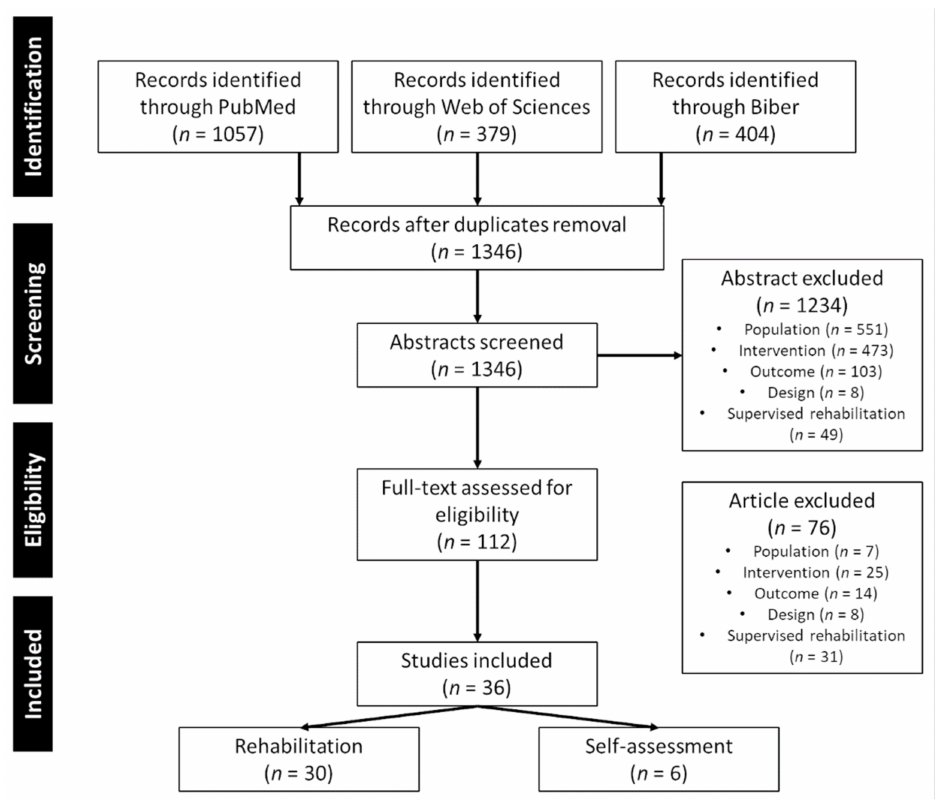
Figure 1. Flowchart of study